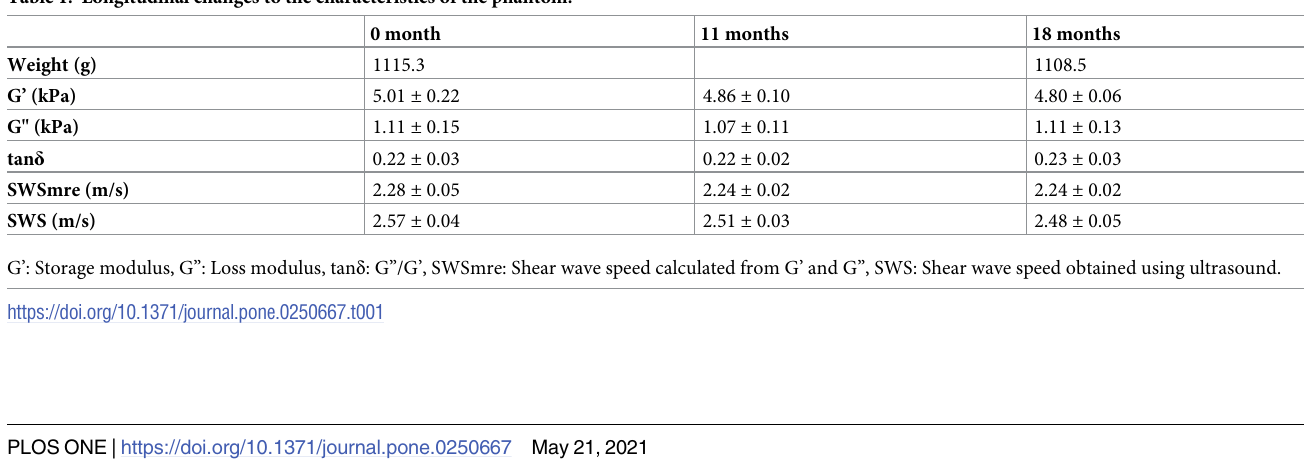
Table 1. Longitudinal changes to the characteristics of the